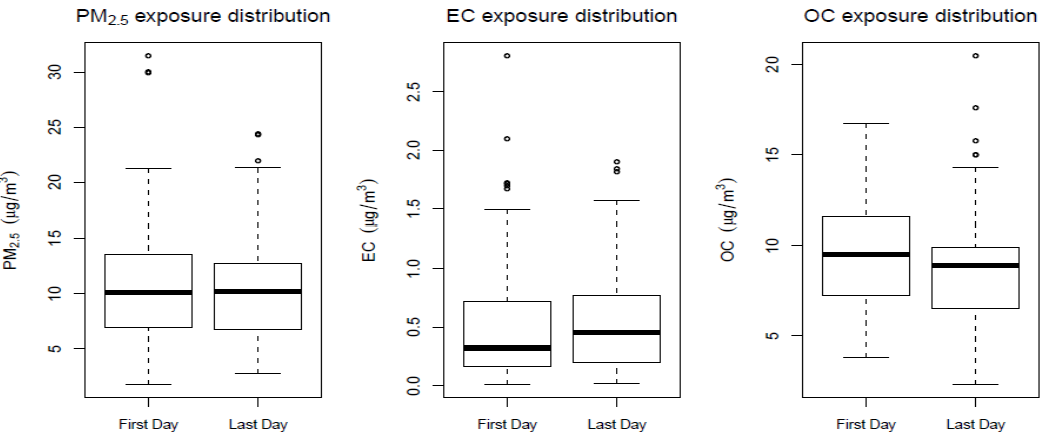
Figure 1. Boxplots for PM , EC and OC levels assigned to study participants for the first 2.5 and last days of the